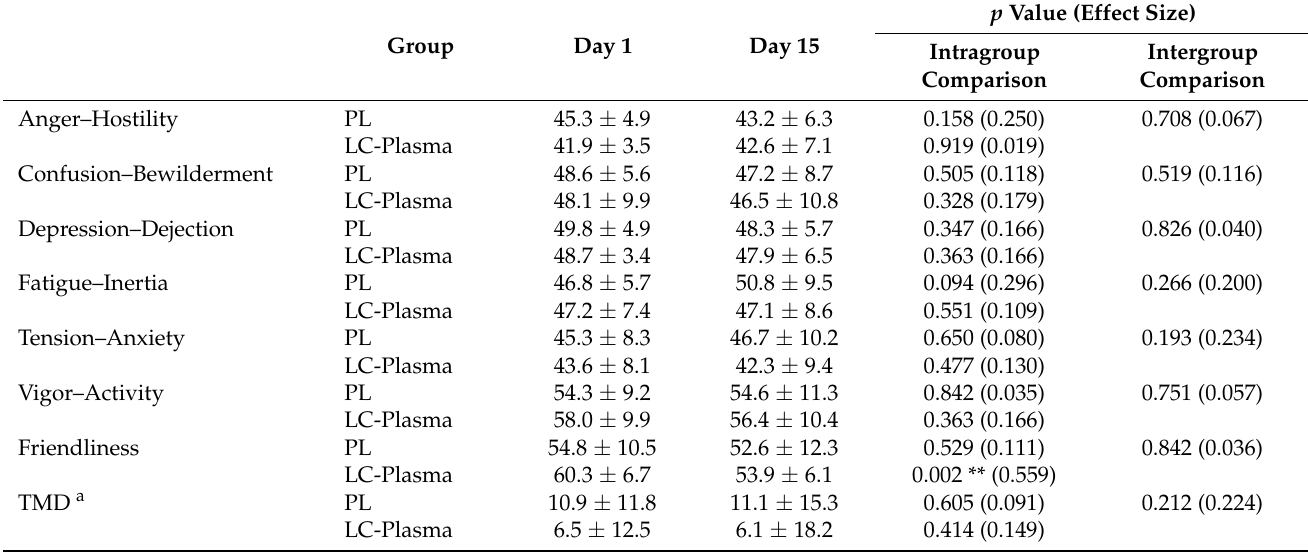
Table 4. Changes in POMS2 scores during the continuous exercise period.